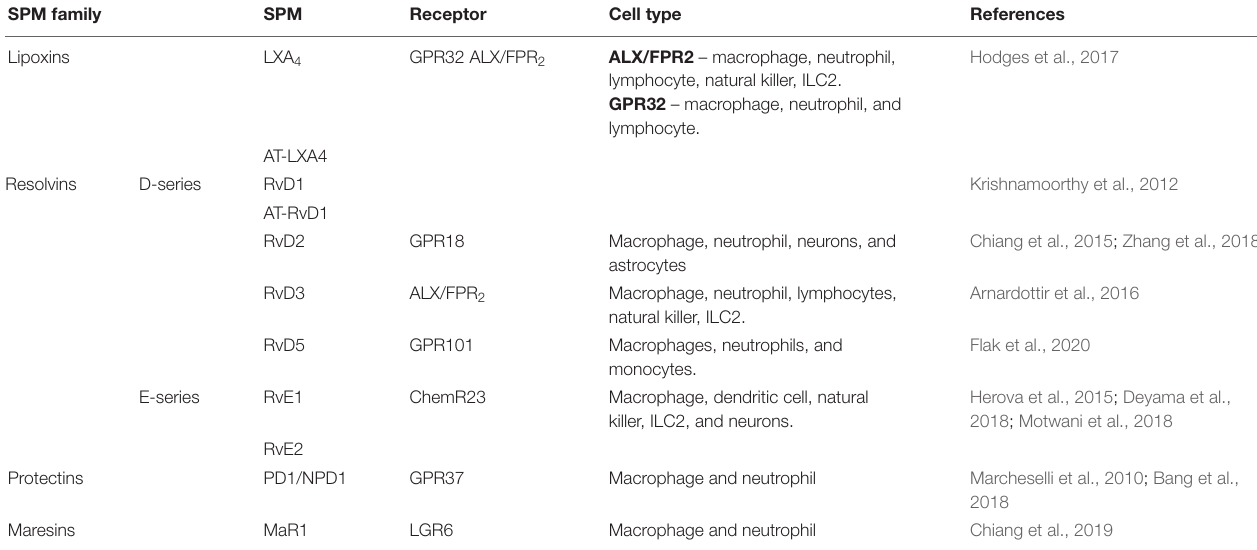
TABLE 1 | SPMs and their